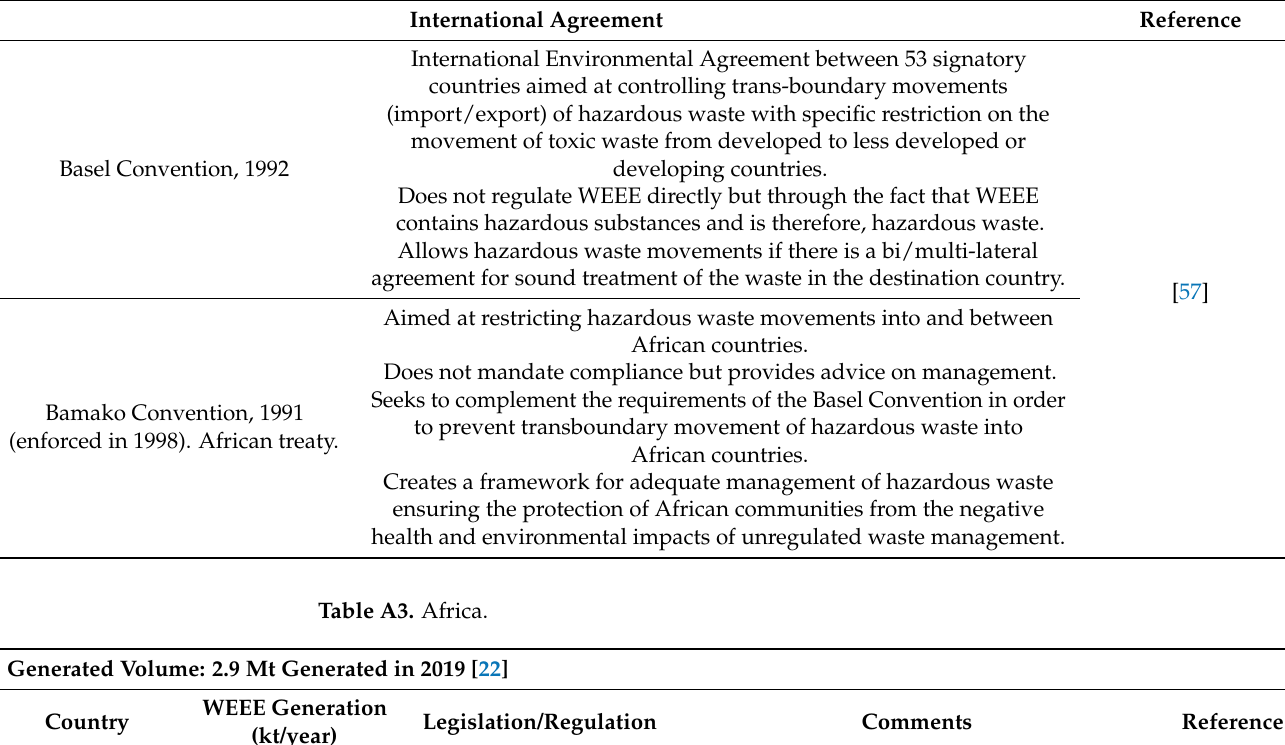
Table A2. Africa